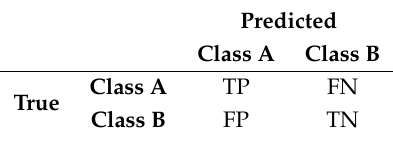
Table 4. Confusion matrix. TP = True Positives, TN = True Negatives, FP = False Positives, FN = False Negatives.